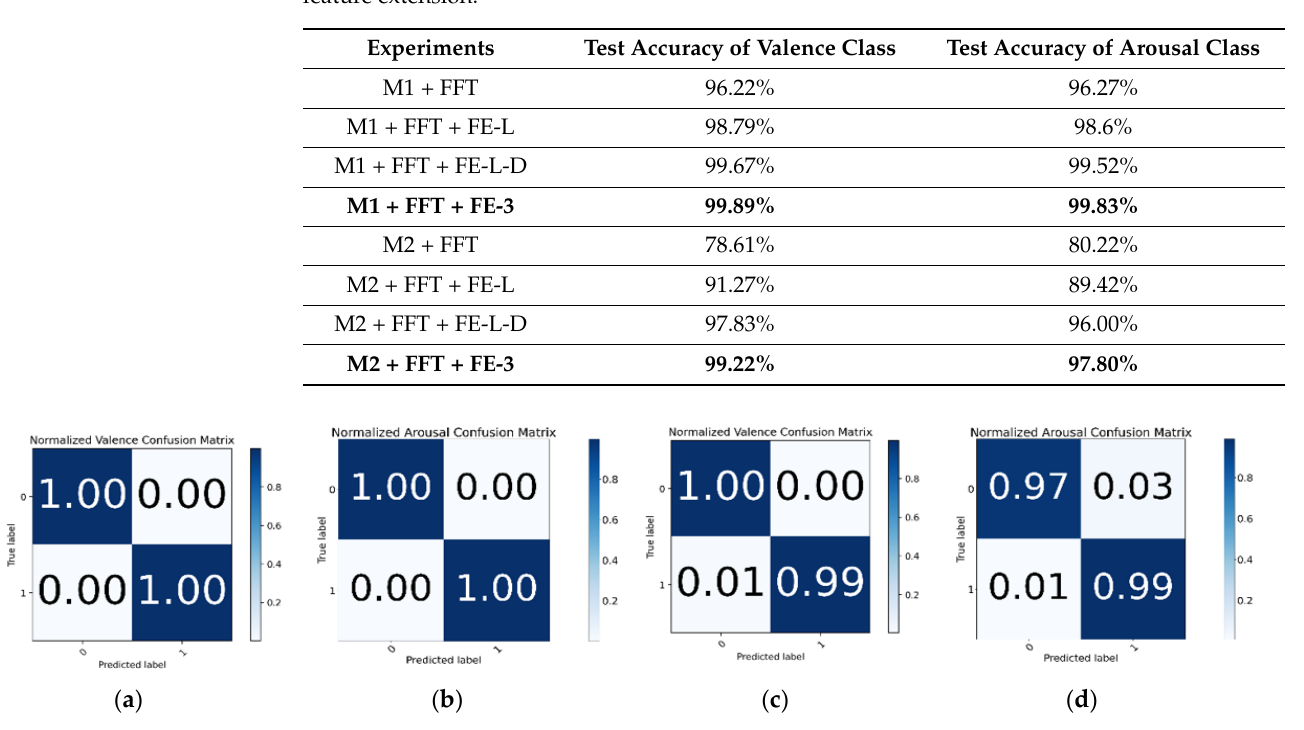
Figure 10. Confusion matrix of valence and arousal label for M1 + FFT + FE ‐ 3 and M2 + FFT + FE ‐ 3 experiment. ( a ) M1 + FFT + FE ‐ 3 experiment on Valence; ( b ) M1 + FFT + FE ‐ 3 experiment on Arousal; ( c ) M2 + FFT + FE ‐ 3 experiment on Valence; ( d ) M2 + FFT + FE ‐ 3 experiment on Arousal.